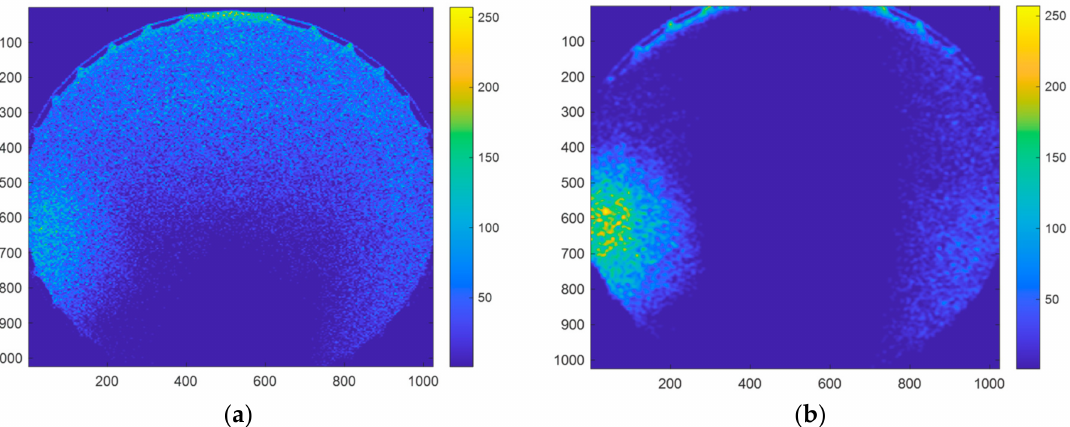
Figure 2. Two types of simulated stray light background gray-scale images. ( a ) the first type; ( b ) the second type.